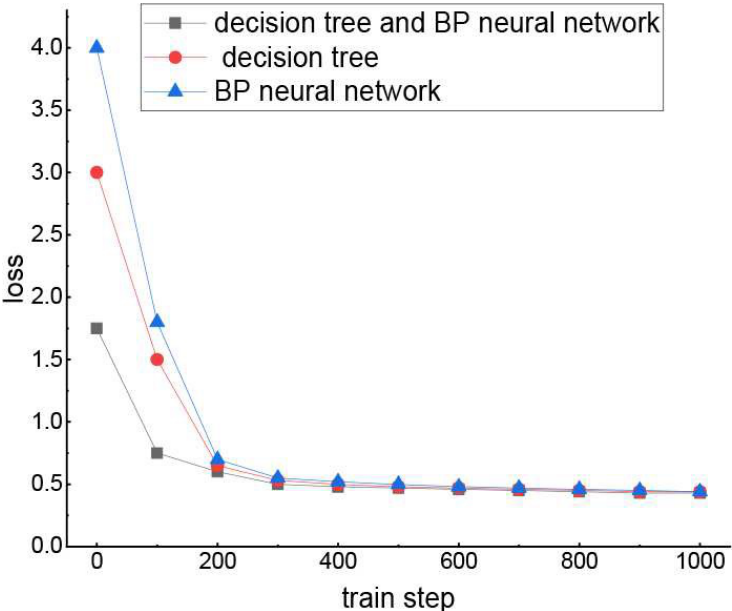
Fig. 3 Neural network error curve